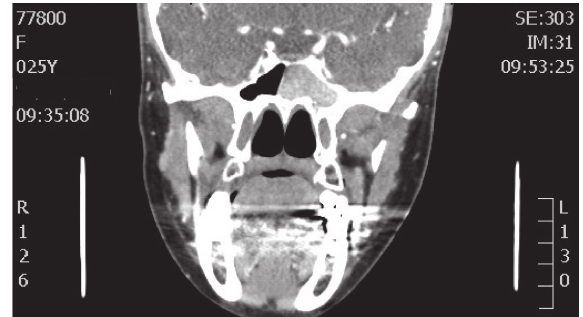
Figure 8: 0-degree intraoperative endoscopic view fungal balls filling both left maxillary and sphenoid sinuses.